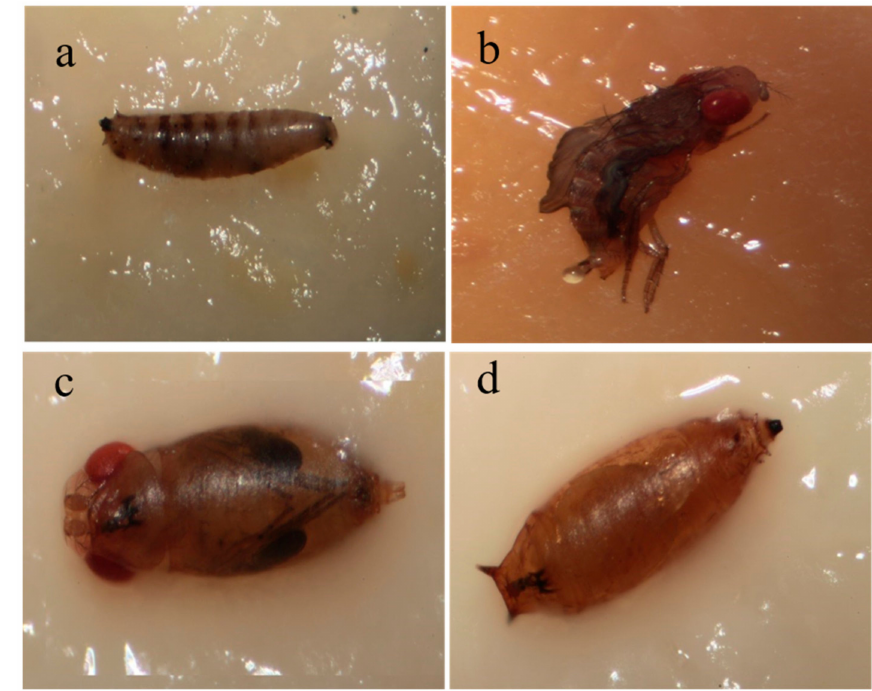
Figure 1. Appearance of Drosophila suzukii specimens after treatment with Photorhabdus luminescens . ( a ) Dead larva that fed on diet containing P. luminescens . ( b ) Dead adult, fed as a larva on diet containing P. luminescens . ( c ) Deformed adult, dipped in P. luminescens solution as a pupa. ( d ) Live D. suzukii female pupa, dipped as a larva in tryptic soy broth (TSB) medium